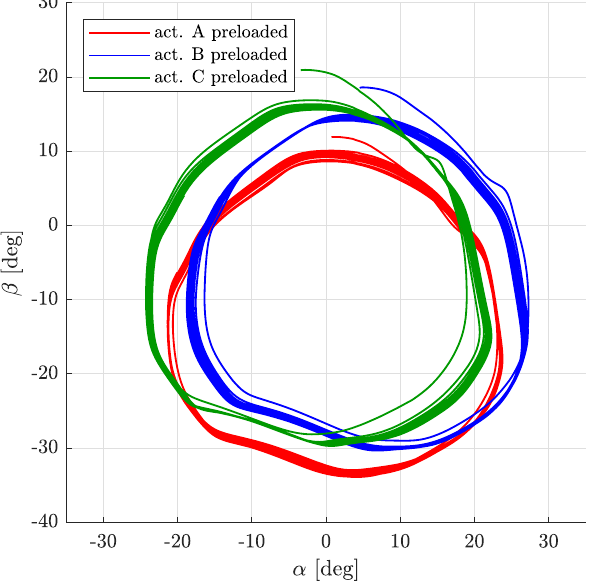
Figure 13. The figure shows the angular response for each of the three experiments in which one of the three actuators is preloaded, i.e., inflated to 1.3bar for 5min. Then, sinusoidal set point trajectories for ∆ p α ,SP and ∆ p β ,SP are commanded, resulting in a circle in the α - β -plane. Thereby, ¯ p is set to ambient pressure. The procedure is repeated for actuators B and C being preloaded and the same pressure setpoint trajectories are commanded. The recorded circles are shifted away from the particular actuator that was preloaded. Within each experiment, the single realizations of the circle show little variation, emphasizing the good repeatability achievable with the